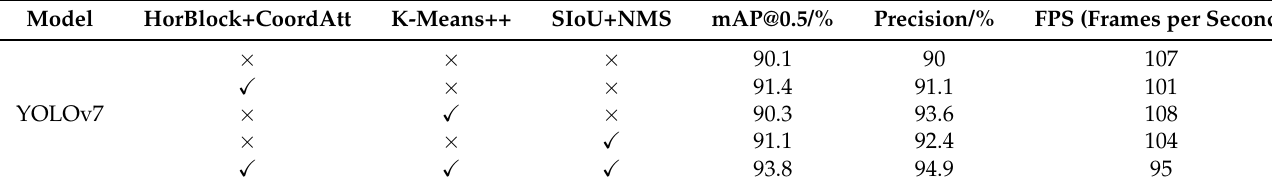
Table 7. Ablation experiment results.